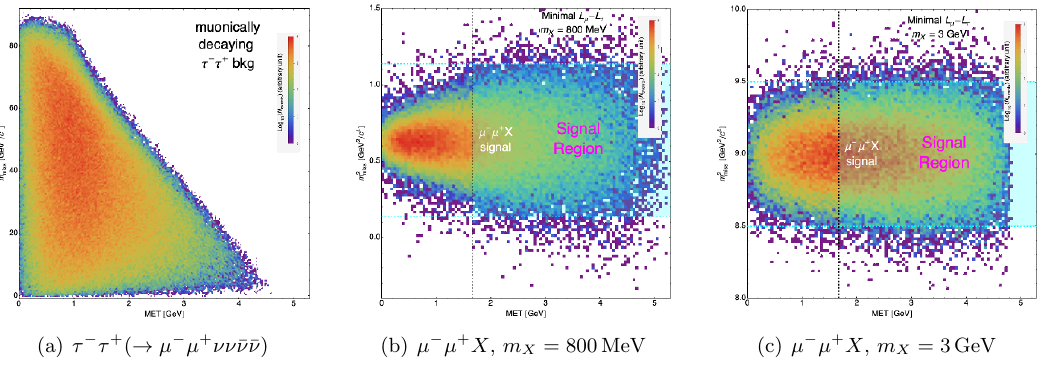
Figure 11 . Distributions of SM background events (cid:28) (cid:0) (cid:28) + ( (invisible) signal events for larger X boson masses ( m X = 800 MeV ; 3 GeV) on the plane of ( =E , m 2 ) T miss